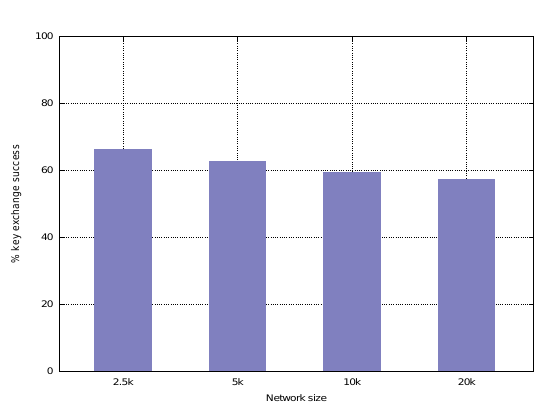
Figure 15. Variations of key exchange success rates for different network sizes (ER topology, capped by 64 hops max per